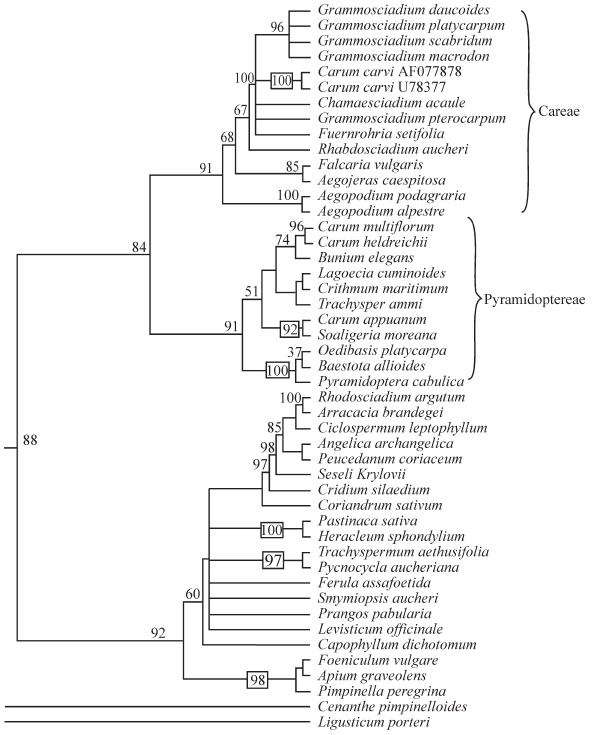
Figure 2 - Strict consensus tree of the 180 maximum parsimony trees (analysis with indels) with bootstrap support above